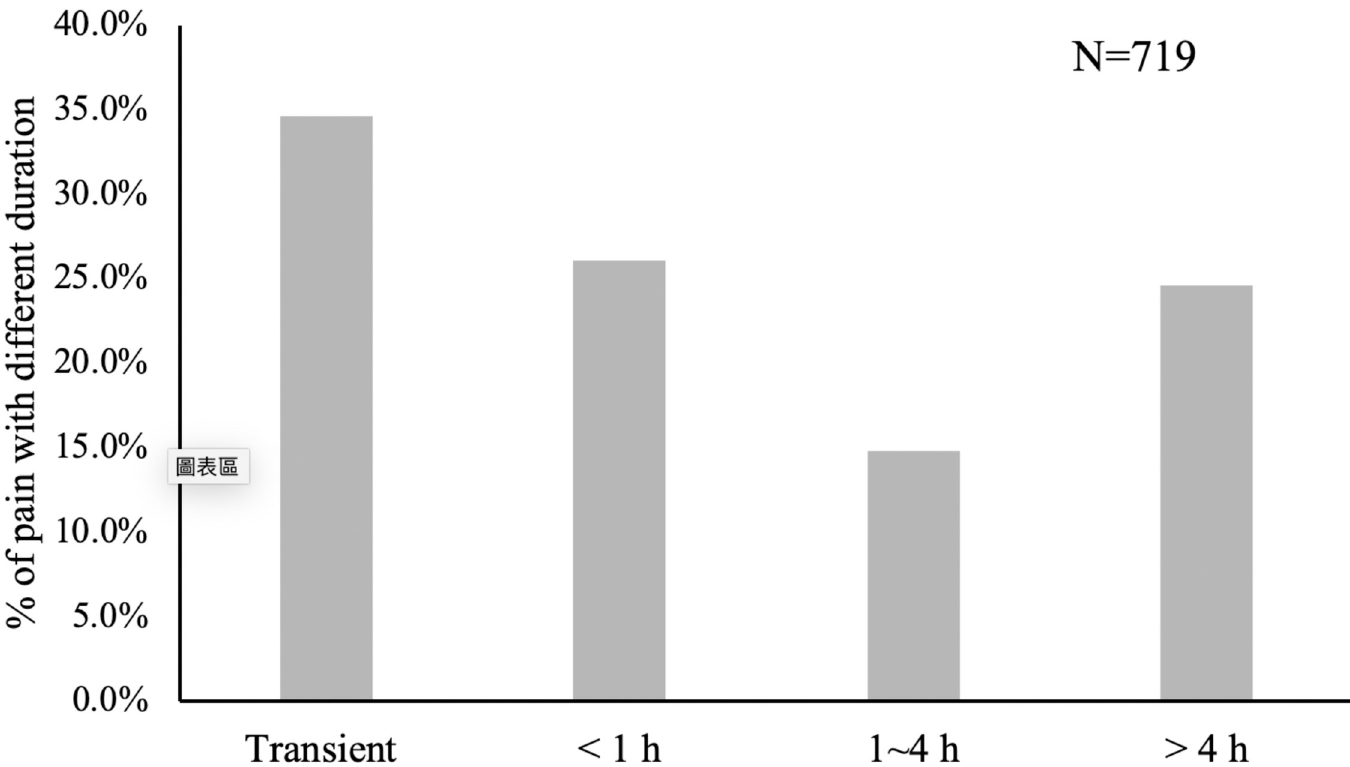
Fig 2. Severe and persistent pain. Seven hundred and nineteen patients had experienced pain within the last 24 hours when responding to the questionnaire. The duration of pain within the last 24 hours was divided into 4 groups titled: transient, < 1 hour, 1–4 hours, and > 4 hours. The percentage of each group is